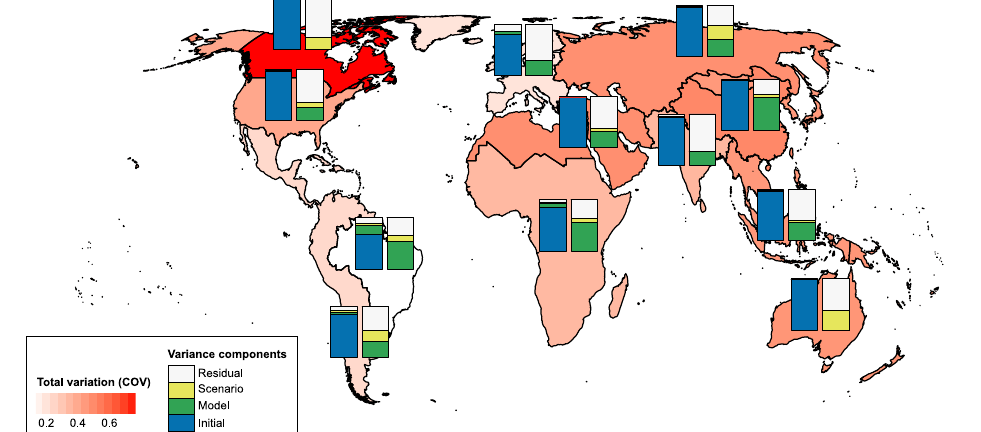
Figure 2. Variation (expressed as coefficients of variation) in pasture projections for 12 world regions in 2030 (shading of the background map). The left bar plots show the relative contribution (as a percentage) of initial variation (pasture area in relation to values reported by FAO (2015) for the year 2010), model-related variation (model type and spatial configuration), and scenario-related variation to the total variation in a region. The right bar plots show the relative contribution (as a percentage) of variance components to the part of total variation that cannot be attributed to initial variation. The figure is based on 11 regional and spatially explicit land-use change models as described in Prestele et al. (2016). Methodological details can be found in Supplement Sect. S2.1 (Table S2) and in Alexander et al.